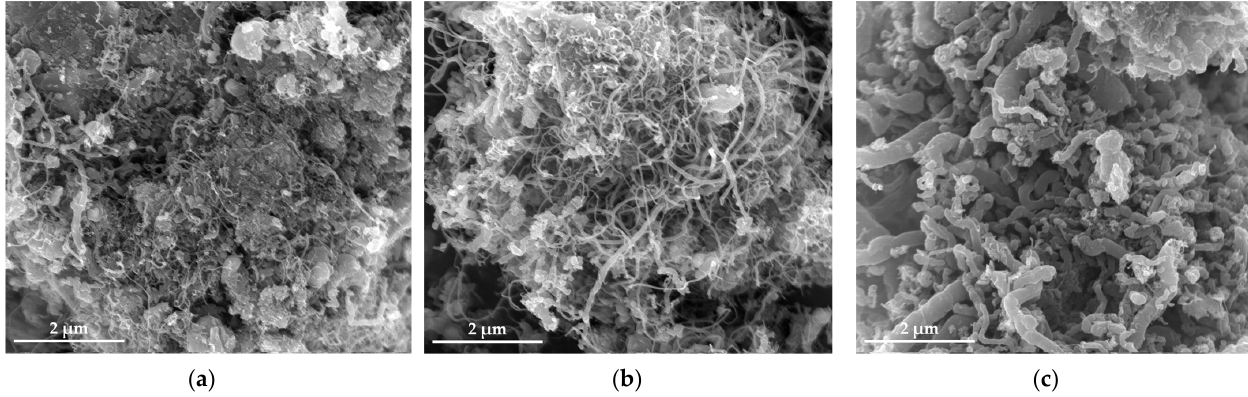
Figure 11. SEM images of CNTs synthesized under a C 2 H 2 flow rate of 100 ( a ); 200 ( b ); 300 sccm ( c ).